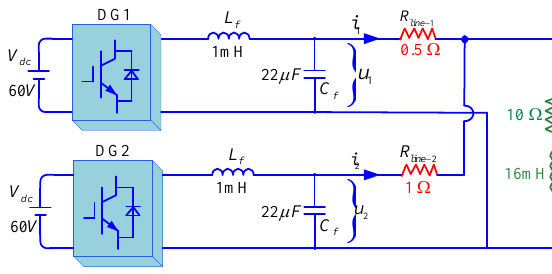
Figure 16. Main circuits of the experiment system.